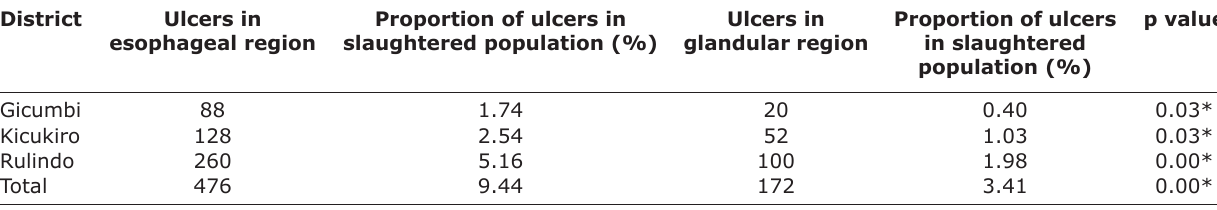
Table-6: Overall occurrence of esophageal and glandular gastric ulcers according to district. District Ulcers in esophageal region